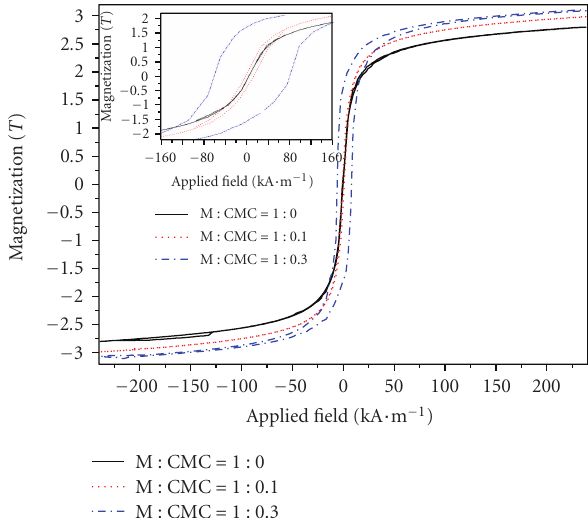
Figure 4: Variation of magnetization with applied field. The insert shows the part of the curve near the